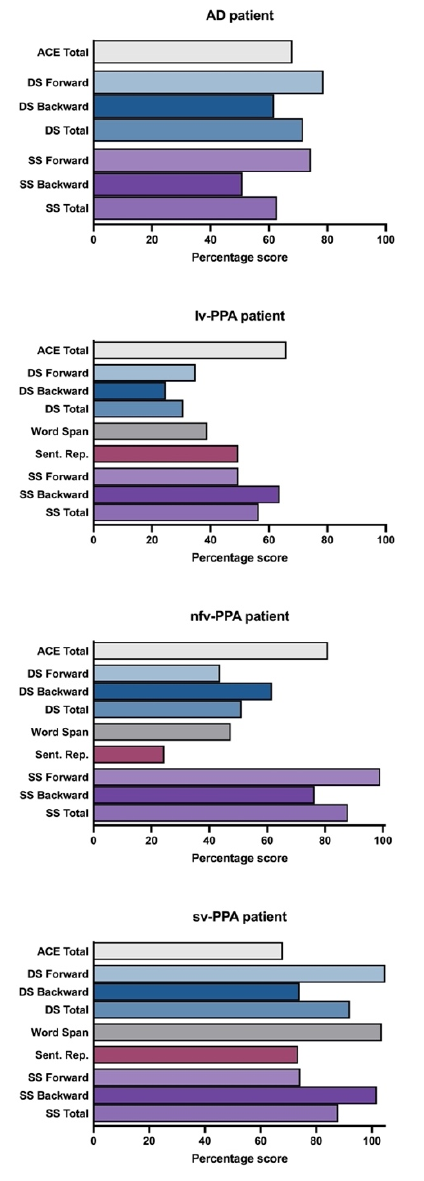
Figure 6. Short-term and working memory performances represented as percentage scores of normal performance (i.e., the patient’s score divided by a control mean, times by 100). The ACE total bar charts are the patient’s raw score on this measure. Control means taken from Foxe, Irish [4]. Notes, ACE: Addenbrooke’s Cognitive Examination-III; DS: Digit Span; Sent. Rep: Sentence Repetition; SS: Spatial Span.